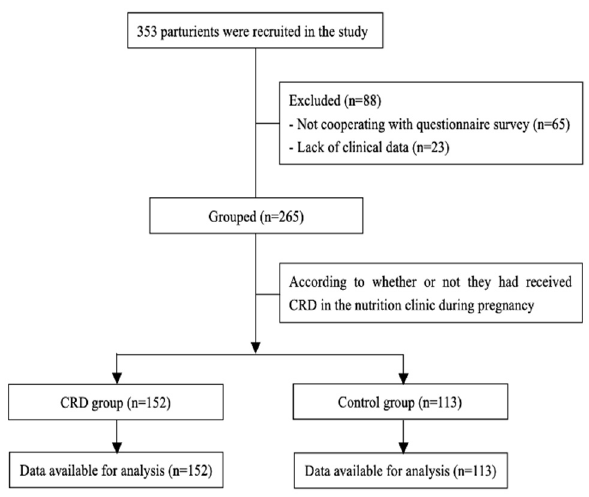
Figure 1. Flow of participants in the study.